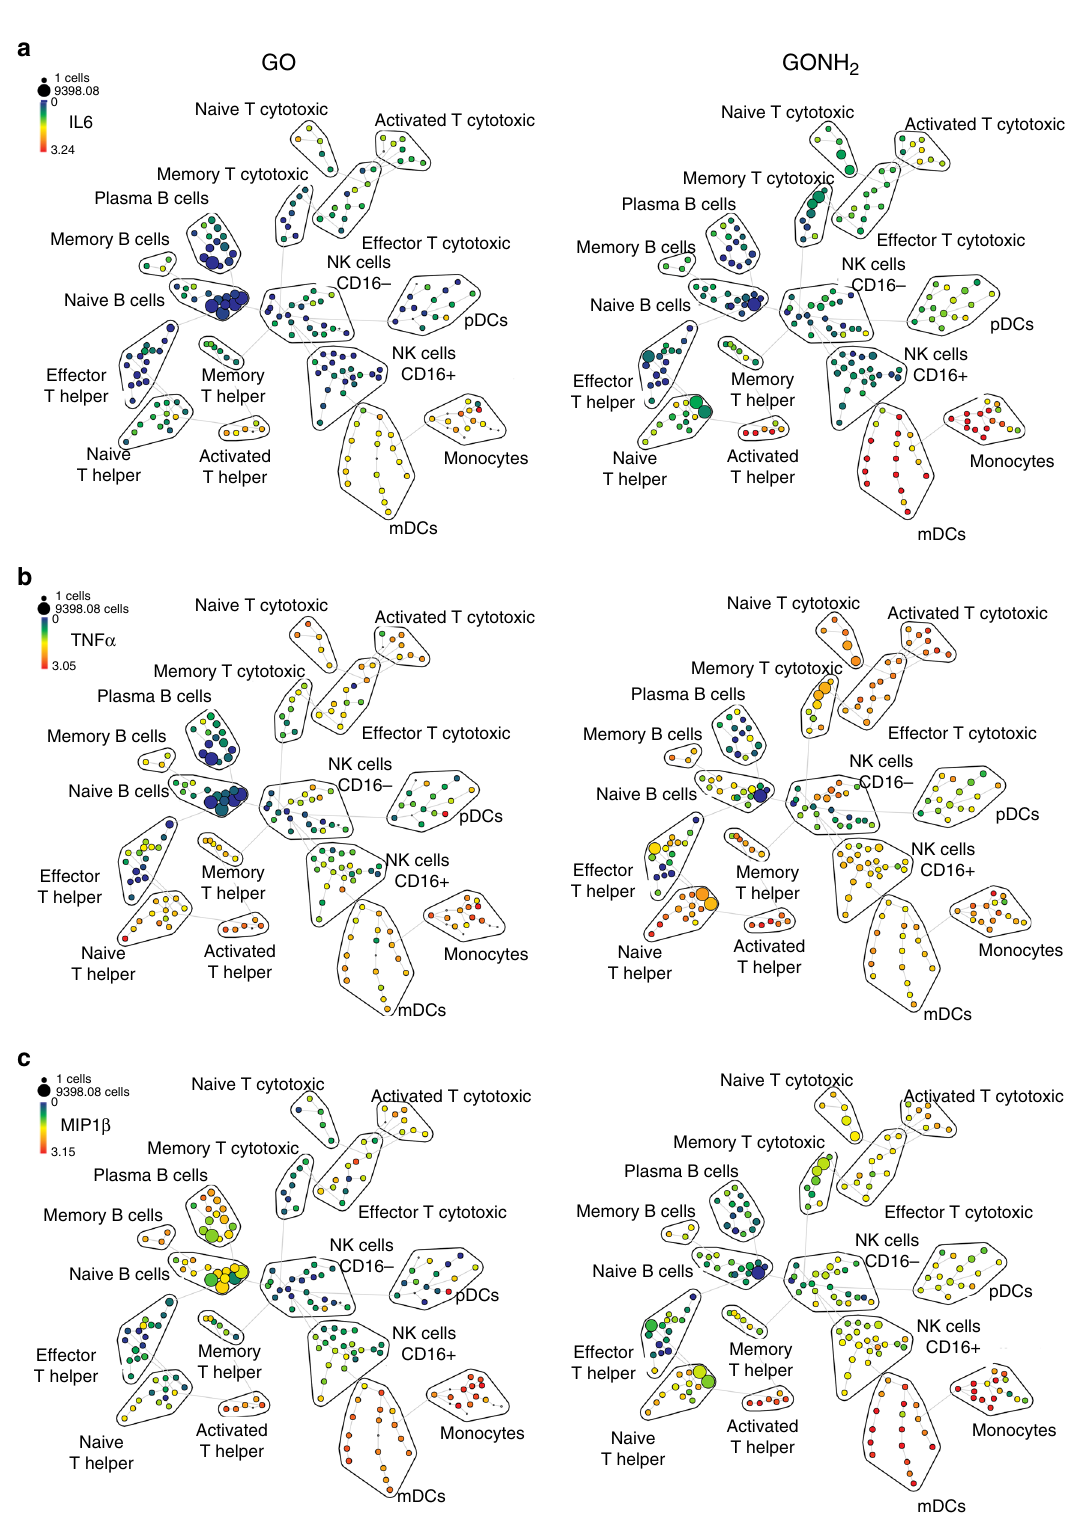
Fig. 3 Summary of SPADE analysis of signi fi cantly secreted cytokines. The tree plots were constructed in the same way of Fig. 1. Node color is scaled to the median intensity of marker expression of the cells within each node, expressed as a percentage of the maximum value in the data set. The spade trees show the median expression intensity of a IL6; b TNF α , and c MIP1 β , for GO and GONH 2 -treated samples. The analysis is made out of three